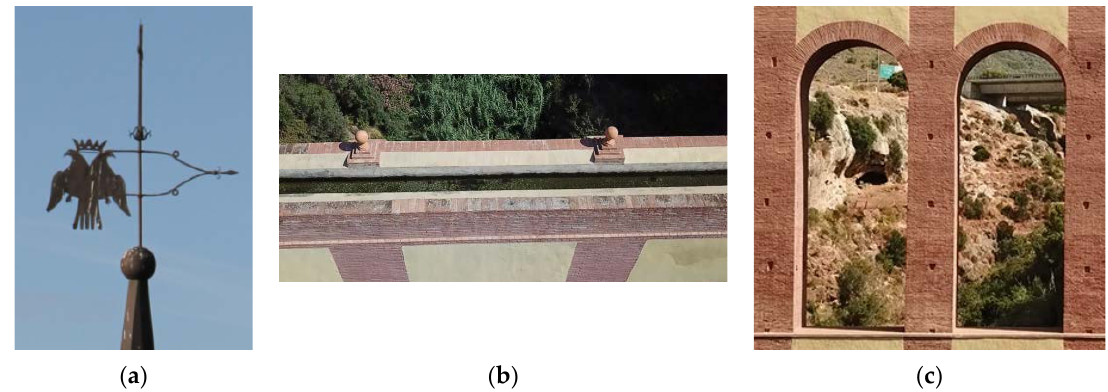
Figure 7. ( a ) Weather vane on the pinnacle; ( b ) aqueduct waterway; ( c ) arches.